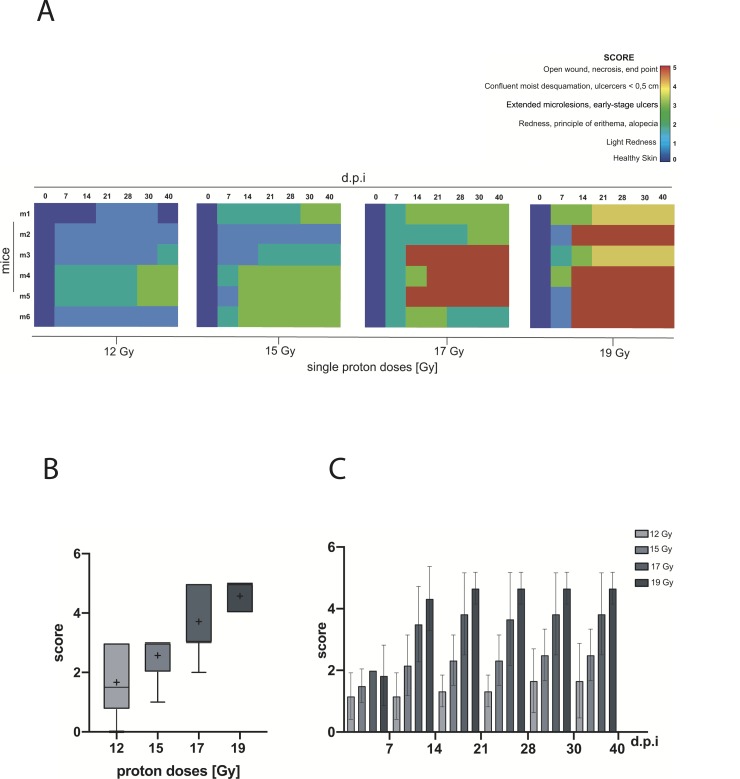
Proton beam-induced skin injury.A) Qualitative “heat map” for single irradiated groups at 7, 14, 21, 28, 30 and 40 d.p.i.. B) Box plot: skin injury score as a function of dose at 40 d.p.i.. The mean score is represented by the plus sign (+). C) Skin injury score progress analysis at 7, 14, 21, 28, 30 and 40 d.p.i for single dose (12, 15, 17 and 19 Gy).